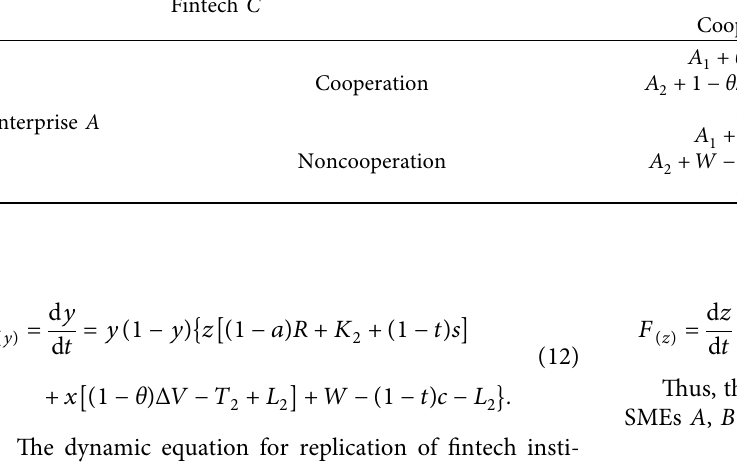
Table 4: Payment matrix of financial institutions nonparticipating in the three-party game. Fintech